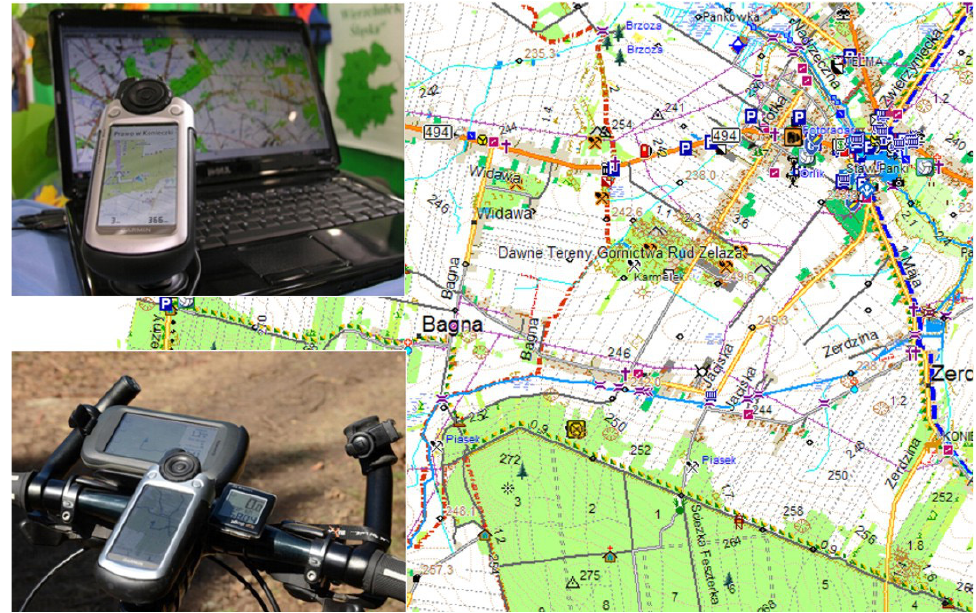
Fig. 4. Cyfrowa mapa topograficzno-turystyczna „Na zachód od Częstochowy” (Digital topographic and tourist map “West of Częstochowa”), KSW Mapa. A digital tourist map for mobile